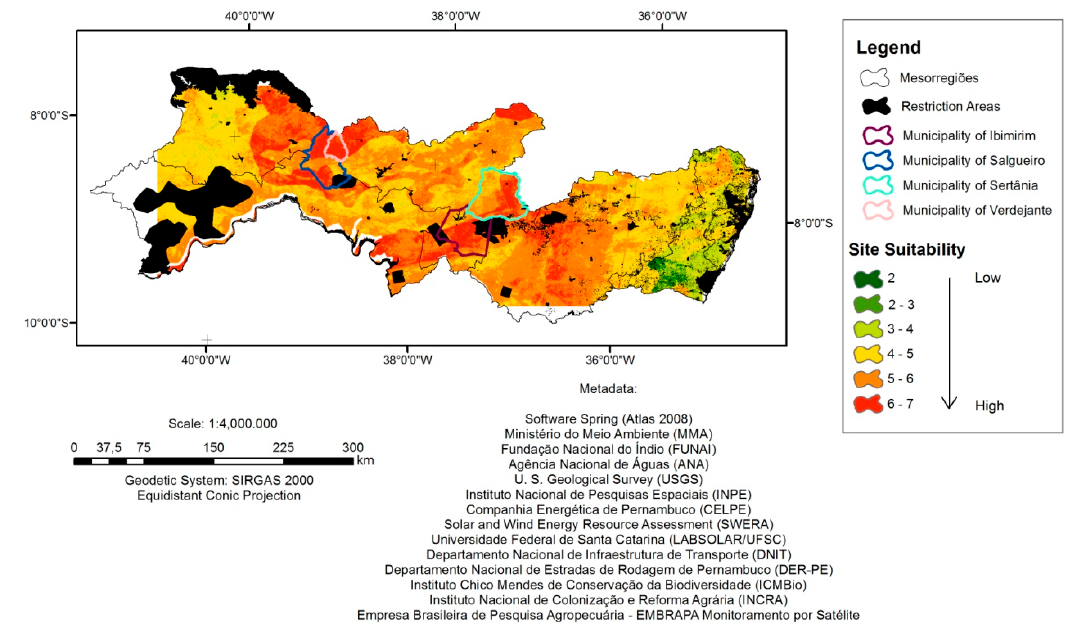
Figure 14. Site Suitability Map for the Installation—Scenario 3.